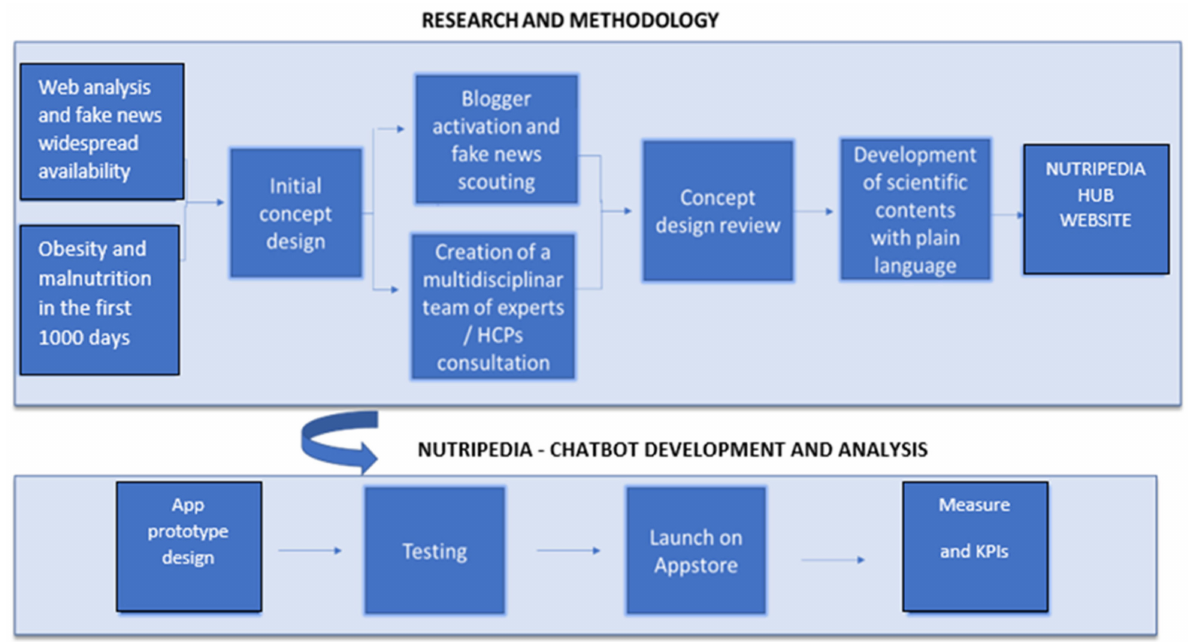
Figure 1. Development process and architecture of the Nutripedia website and Nutripedia Chatbot